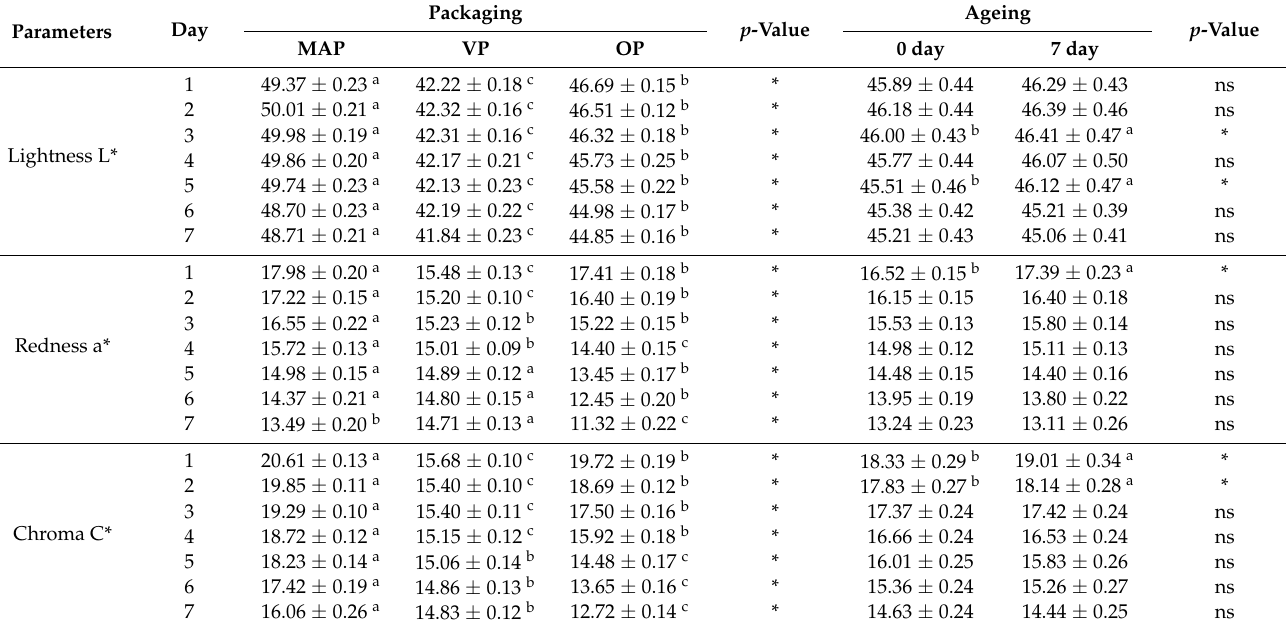
Table 2. Effect of packaging and ageing on color CIE L*, a* and C* of buffalo bulls longissimus lumborum steaks during the 7 days of retail